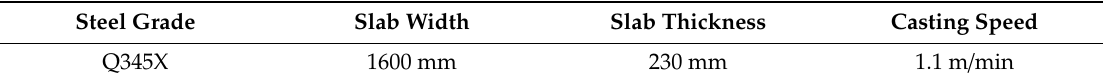
Figure 14. Relationship between amount of water and the water temperature difference.